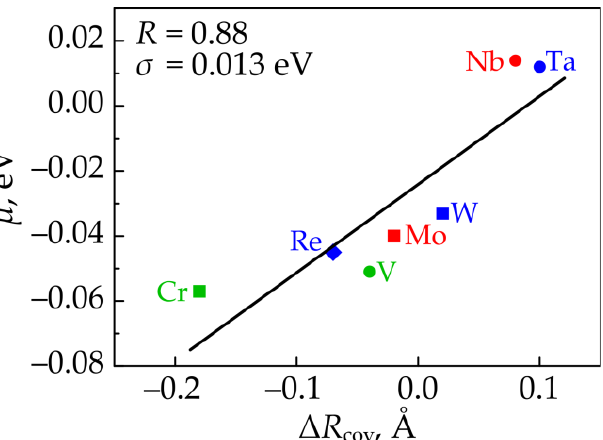
Figure 4. Correlation between mechanical contribution μ to the defect formation energy and dif- ference in the covalent radii between impurity and Ti atoms. The solid lines are obtained by the least-squares method.